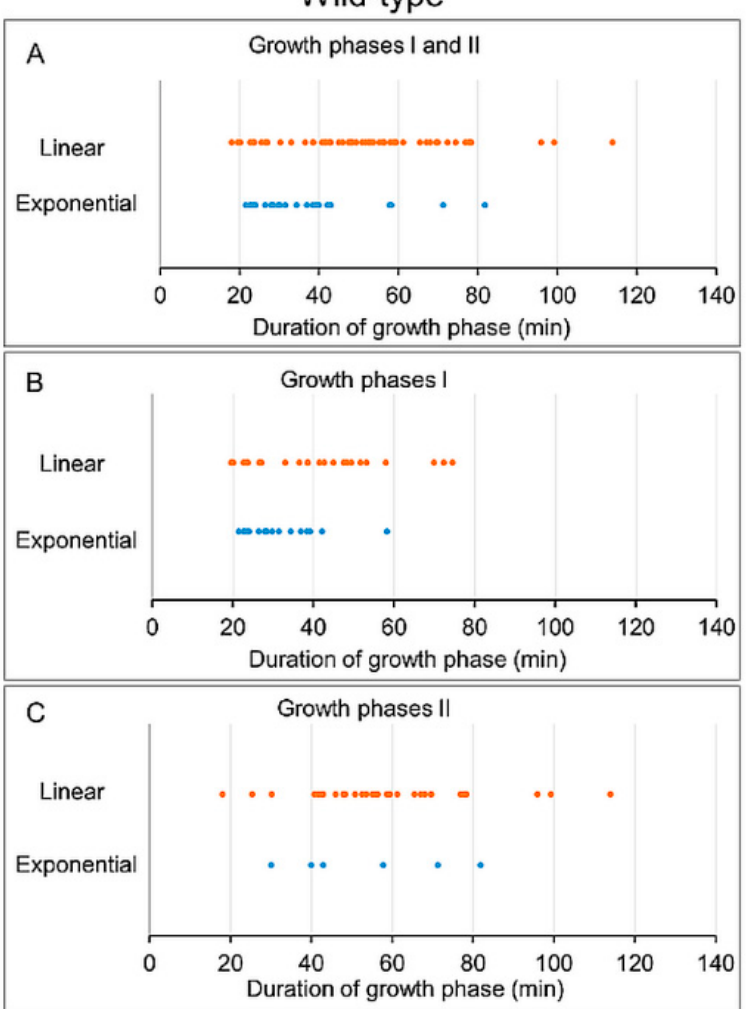
Figure 4. Distribution of the growing segments, examined in the ‘bilinearly’ growing wild-type fission yeast cells. The growth phases are separated by the more adequate fitted model (linear or exponential). The symbols represent the growing segments, whose durations are given in minutes. ( A ) All the growth phases (I and II) are shown. ( B ) Only growth phase I is shown. ( C ) Only growth phase II is shown.